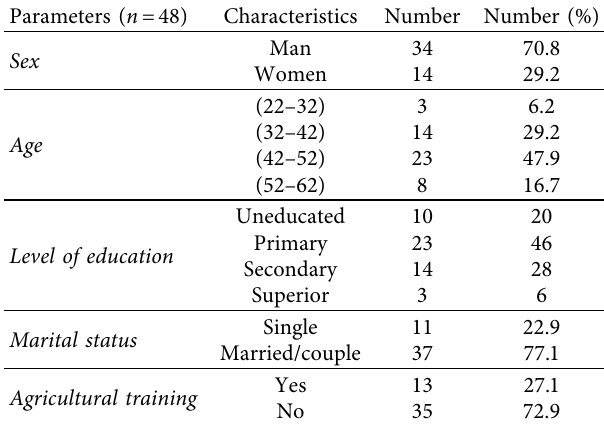
Table 1: Socioprofessional characteristics of